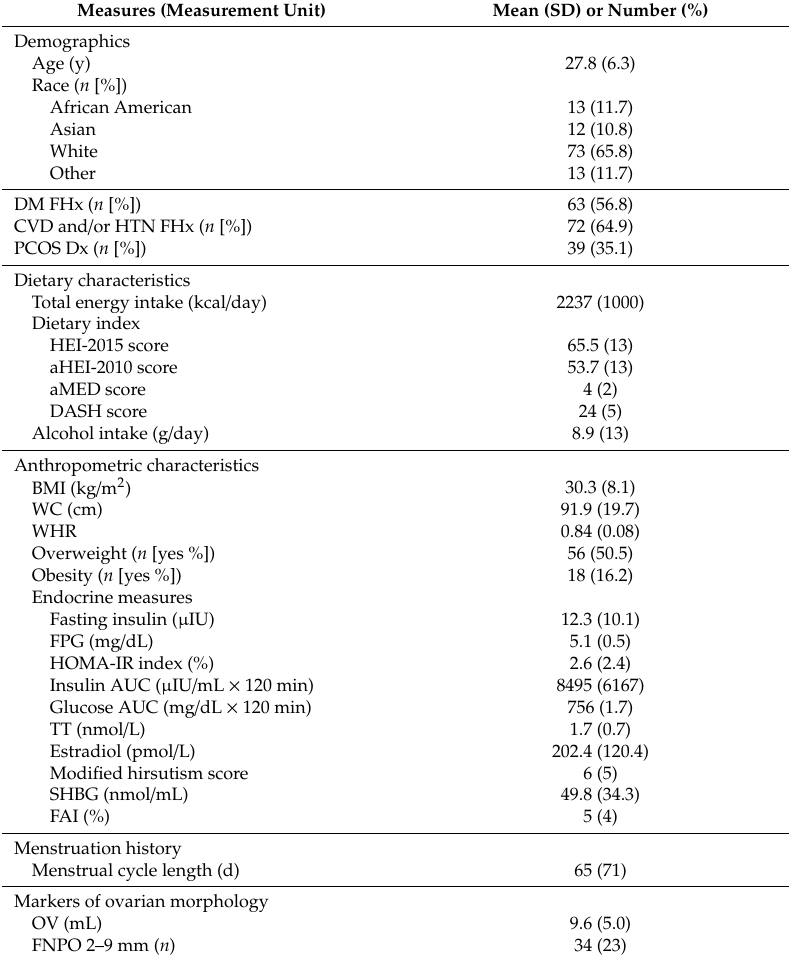
Table 1. Descriptive characteristics of women ( n =